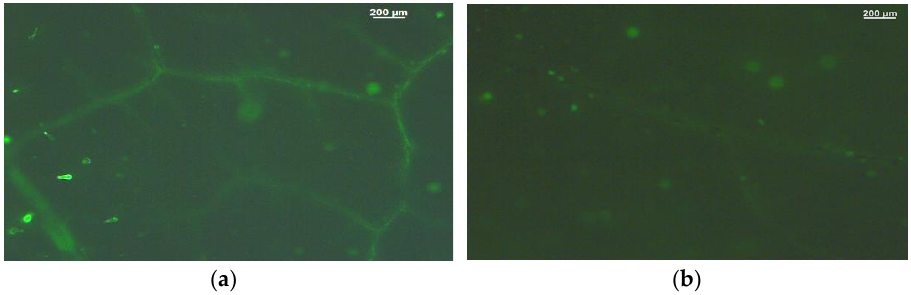
Figure 6. The ROS-specific fluorescence imaging of tomato leaflets stained by 2′, 7′ -dichlorofluorescein diacetate (DCF-DA) after 72 h of foliar spray by either distilled water (control) ( a ); or 1 mM salicylic acid (SA) ( b ). Increased generation of ROS is visible by light green color. Scale Bar: 200 μm.